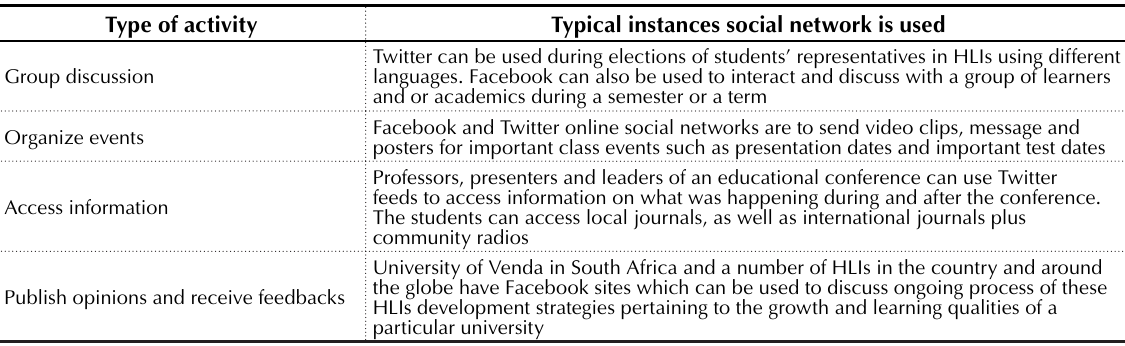
Table 1. Type of activity supported by social networking